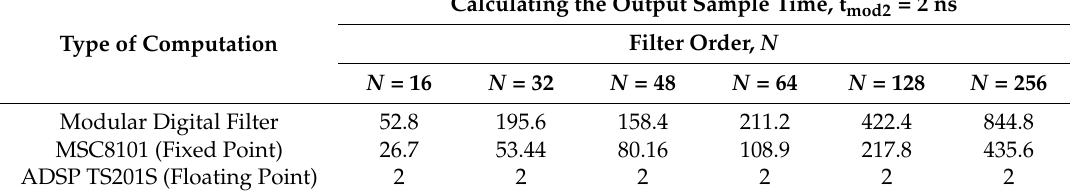
Table 1. Comparative evaluation of the calculation time of the output sample of the non-recursive position filter implemented at the digital signal processing DSP and the modular digital filter at t mod2 = 2